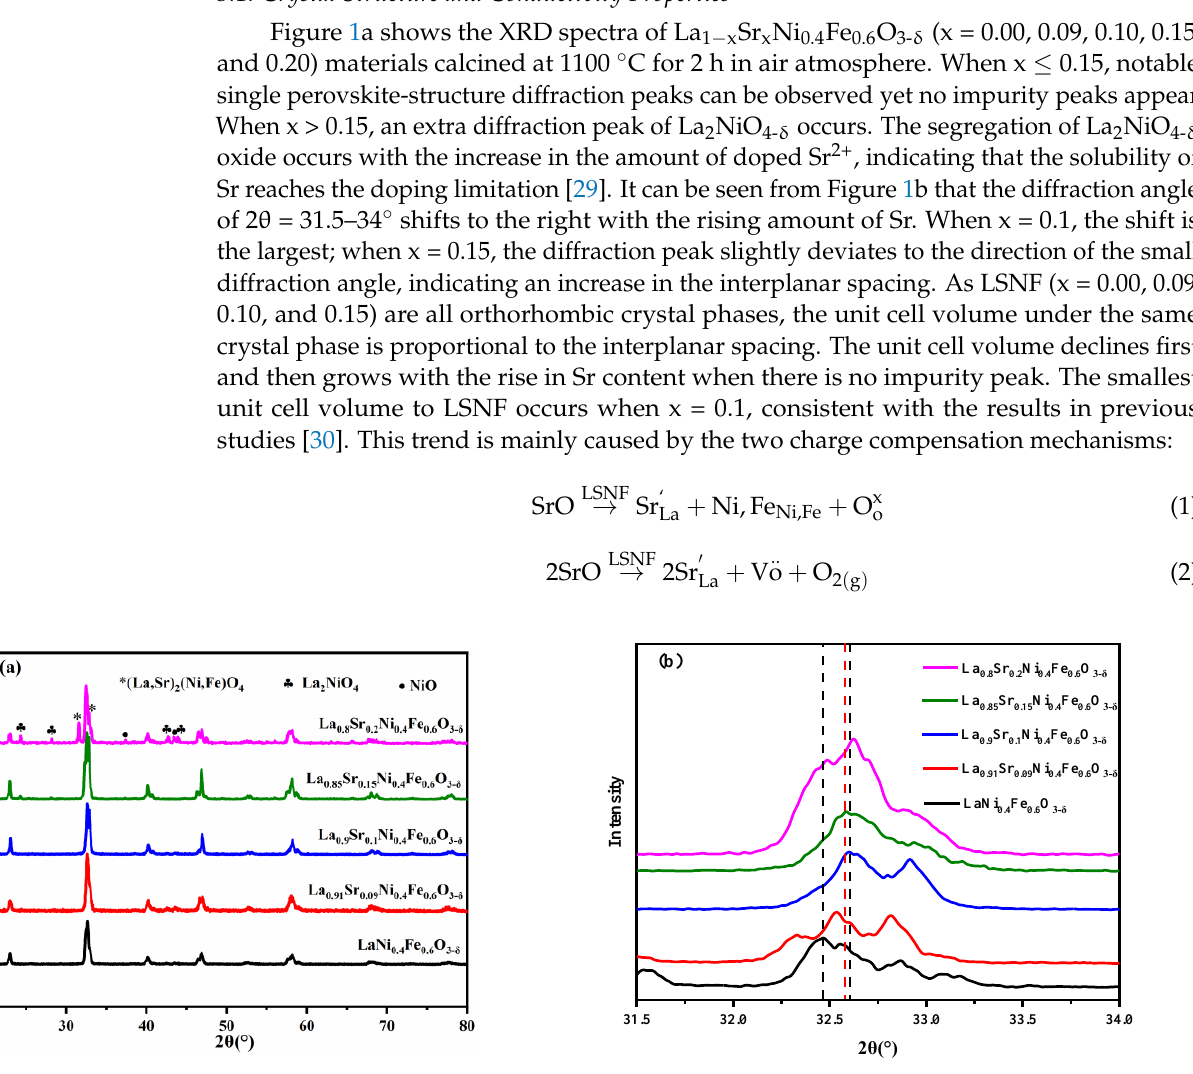
Figure 1. ( a ) XRD spectra and ( b ) partially enlarged XRD peak around 32.5° of La 1-x Sr x Ni 0.4 Fe 0.6 O 3- δ (x= 0.00, 0.09, 0.1, 0.15, 0.20) materials calcined at 1100 °C for 2 h in air.